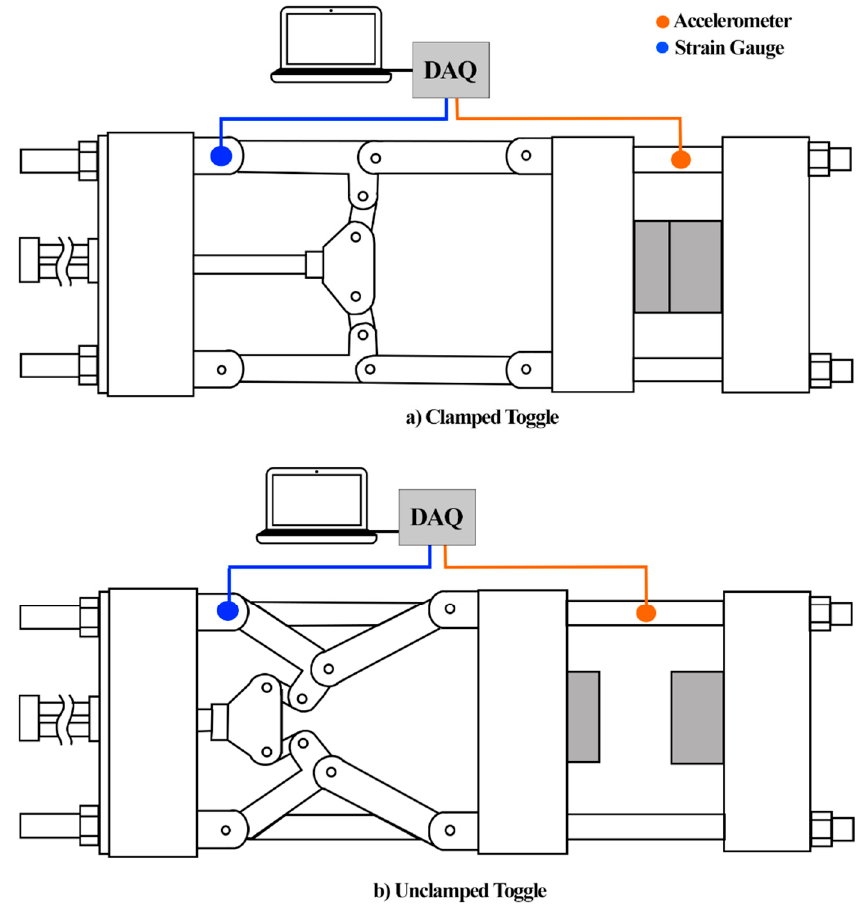
Figure 2. A schematic of the ( a ) clamped and ( b ) unclamped injection molding machine and the mounted sensors.